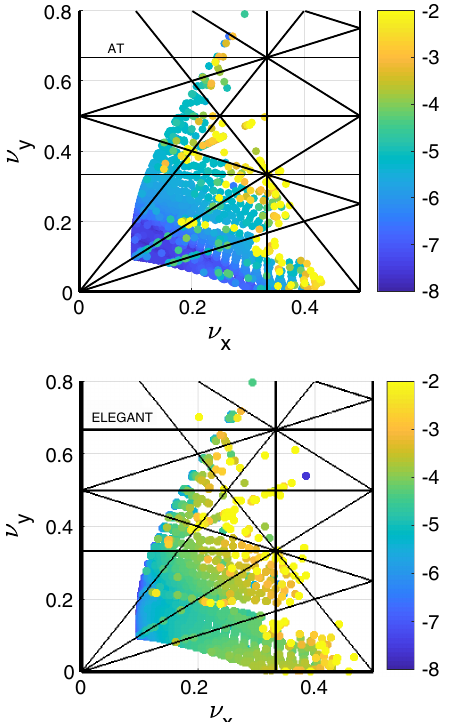
FIG. 8. Tune diagram for frequency map analysis in the x - y plane. The color code represents the detuning over 1024 turns, q (cid:6) (cid:5) ffiffiffiffiffiffiffiffiffiffiffiffiffiffiffiffiffiffiffiffiffiffi þ Δ ν 2 Δ ν 2 , where Δ ν x and Δ ν y are tune changes from log 10 x y the first 512 turns to the second 512 turns.